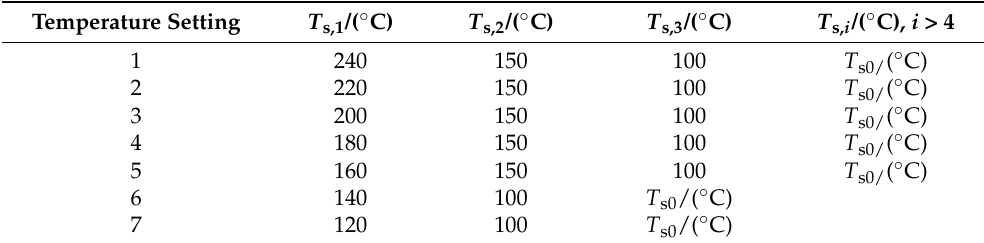
Table 1. Substrate temperature at each layer i , T s, i , during ME of the polymer part of the SLJ for the explored temperature settings.